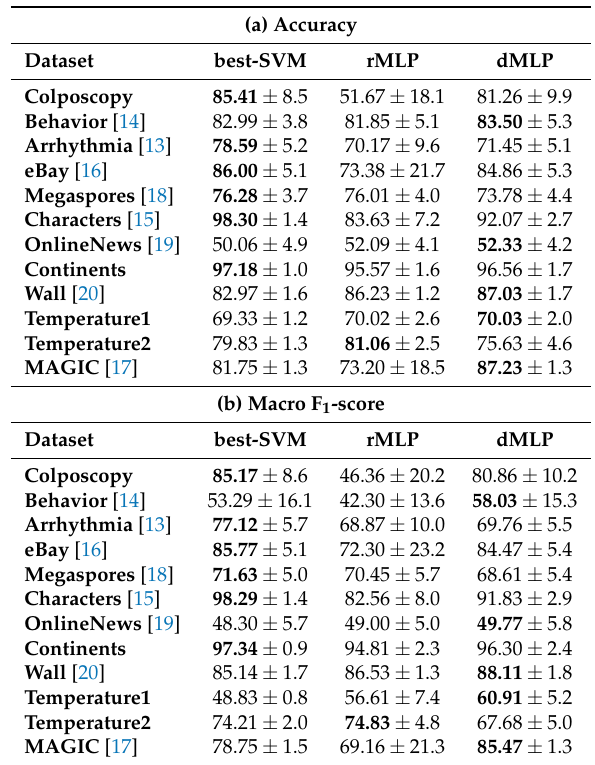
Table 3. Average performance and standard deviation per model on 30 runs for 12 datasets, which are presented in increasing order of their respective cardinality. The evaluated models are: directional SVM with highest average accuracy (best-SVM), MLP trained on top of raw angle values (rMLP), and MLP trained on top of the feature transformation φ ( x ) = ( cos ( x ) ,sin ( x )) (cid:124) (dMLP). Best results are given in